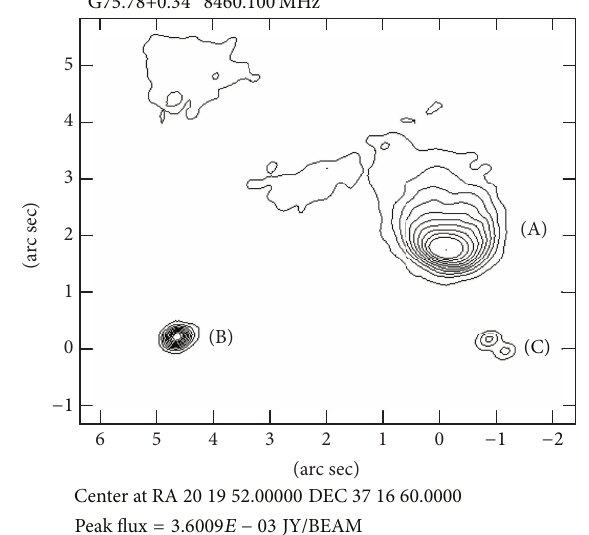
Figure 2: 3.5 cm radio continuum image of G75.78+0.34 obtained with VLA at “A” configuration. Flux levels are 0.36, 0.72, 1.08, 1.44, 1.80, 2.16, 2.52, 2.88, 3.24, and 3.6